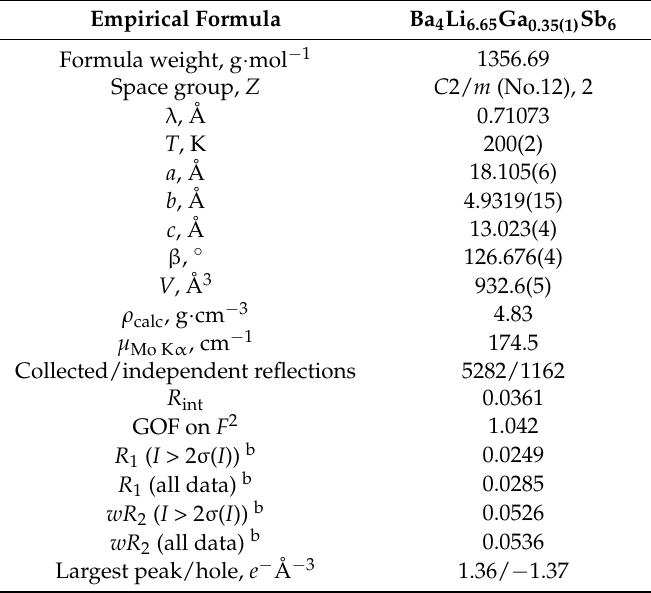
Table 1. Selected crystal structure data and refinement parameters for Ba 4 (Li 1 − x Ga x ) 7 Sb 6 a .